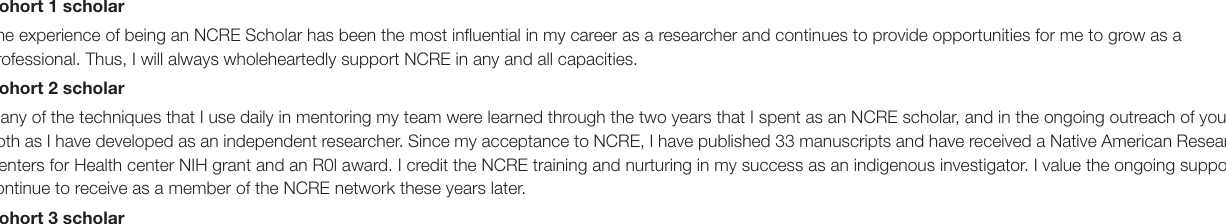
TABLE 2 | Selected evaluation responses from NCRE scholars in Cohorts